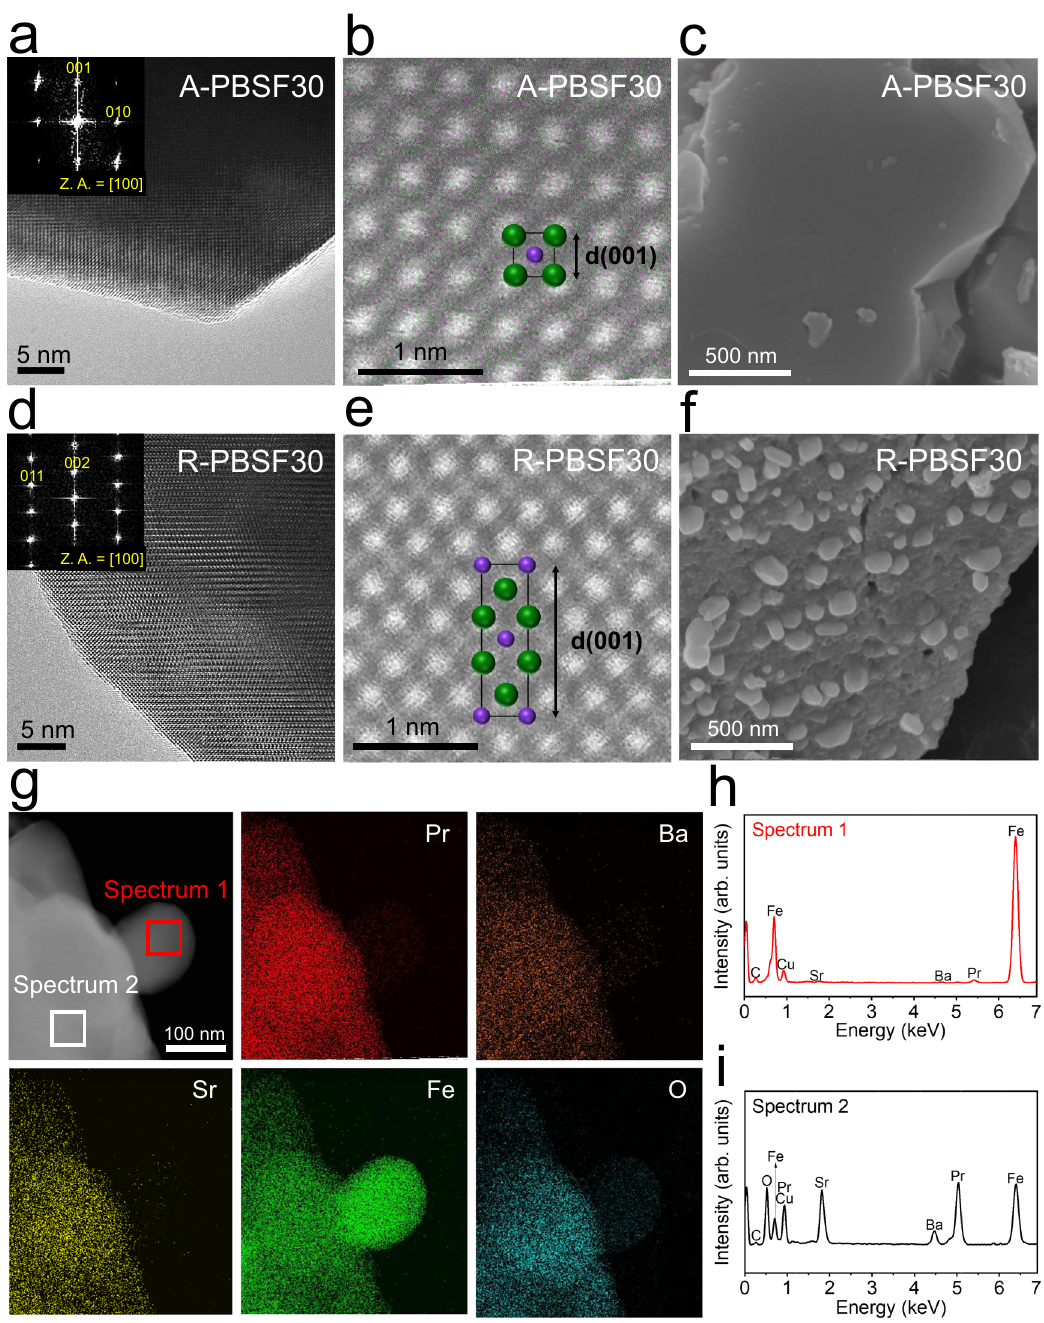
Fig. 3 Electron microscopic analysis. a , b , d , e Transmission electron microscopy (TEM) analysis. a High-resolution (HR) TEM image and the corresponding fast-Fourier transformed (FFT) pattern of Pr 0.5 Ba 0.2 Sr 0.3 FeO 3 − δ (A-PBSF30) with zone axis (Z.A.) = [100] and b high-angle annular dark- fi eld (HAADF) scanning TEM (STEM) image of A-PBSF30 with simple perovskite structure of [100] direction with d-spacing 001. d HR TEM image and the corresponding FFT pattern of (Pr 0.5 Ba 0.2 Sr 0.3 ) 2 FeO 4 + δ – Fe metal (R-PBSF30) with Z.A. = [100] and e HAADF STEM image and the atomic arrangement of R-PBSF30 of [100] direction with d-spacing 001. c , f Scanning electron microscope (SEM) images. SEM images presenting the surface morphologies of